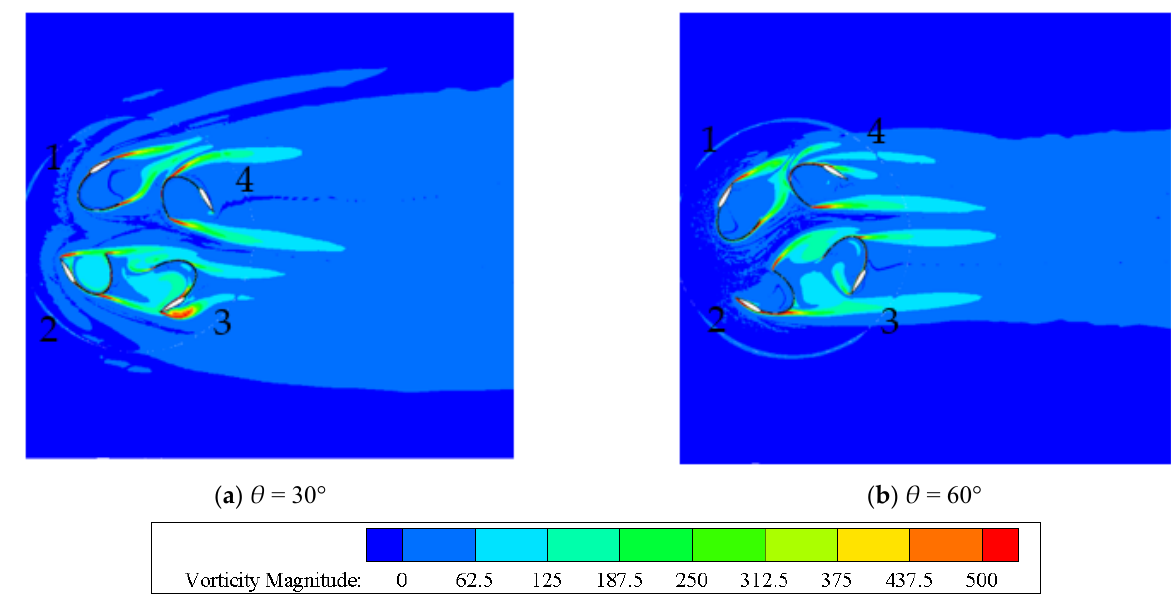
Figure 17. Velocity magnitude of 4-bladed LDCS ( U = 6 m/s): ( a ) θ = 30°; ( b ) θ = 60°.